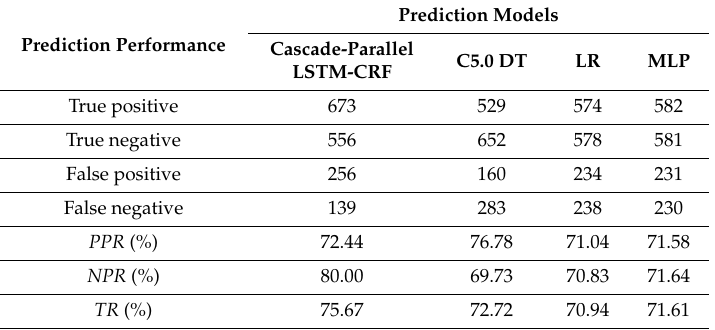
Table 3. Comparison between Landslide prediction performances.